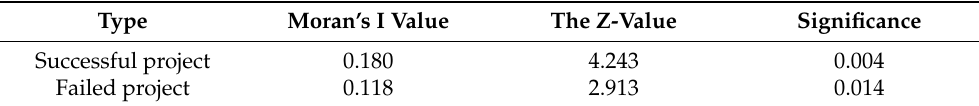
Table 5. The results of the Moran’ I measurement.